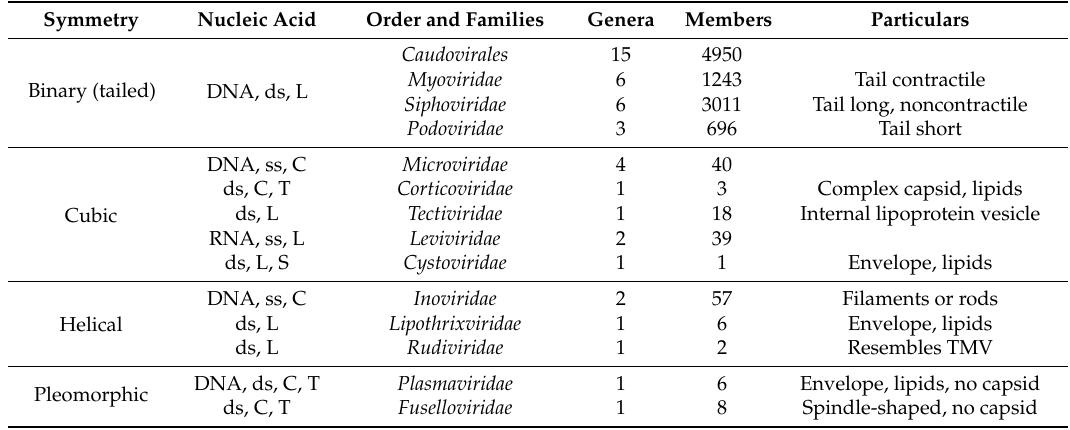
Table 1. Classification and Basic Properties of Bacteriophages [41] .